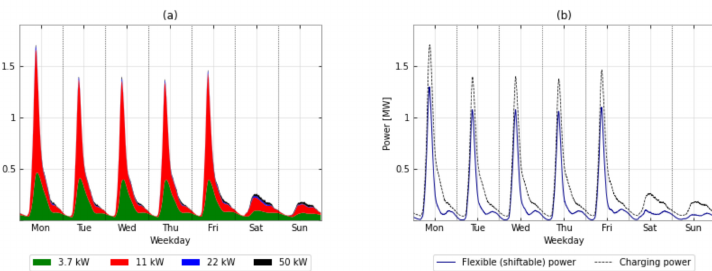
Figure A13. ( a ) User Group C: Charging power profile as a function of the assumed charging power used; ( b ) User Group C: Relation between the charging power profile and the associated flexible (shiftable) power.